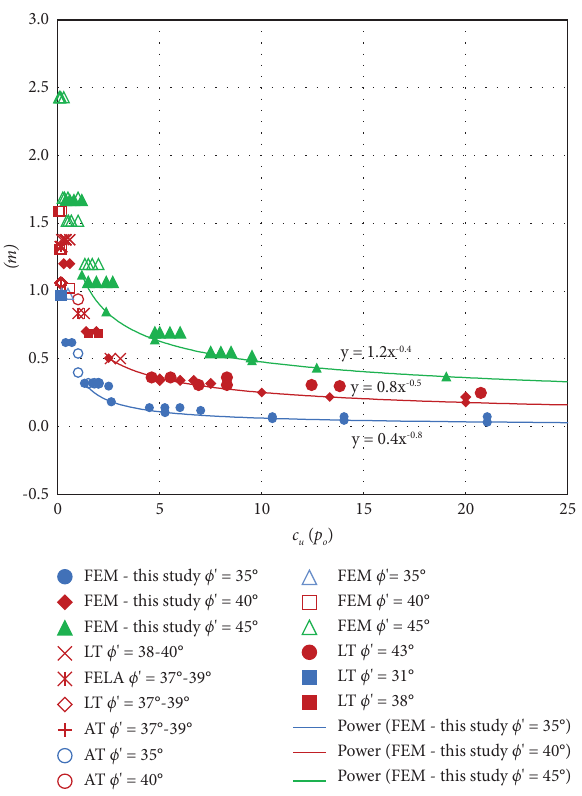
Figure 15: m values versus c u /p o from various studies for an unstabilised granular layer with ϕ ′